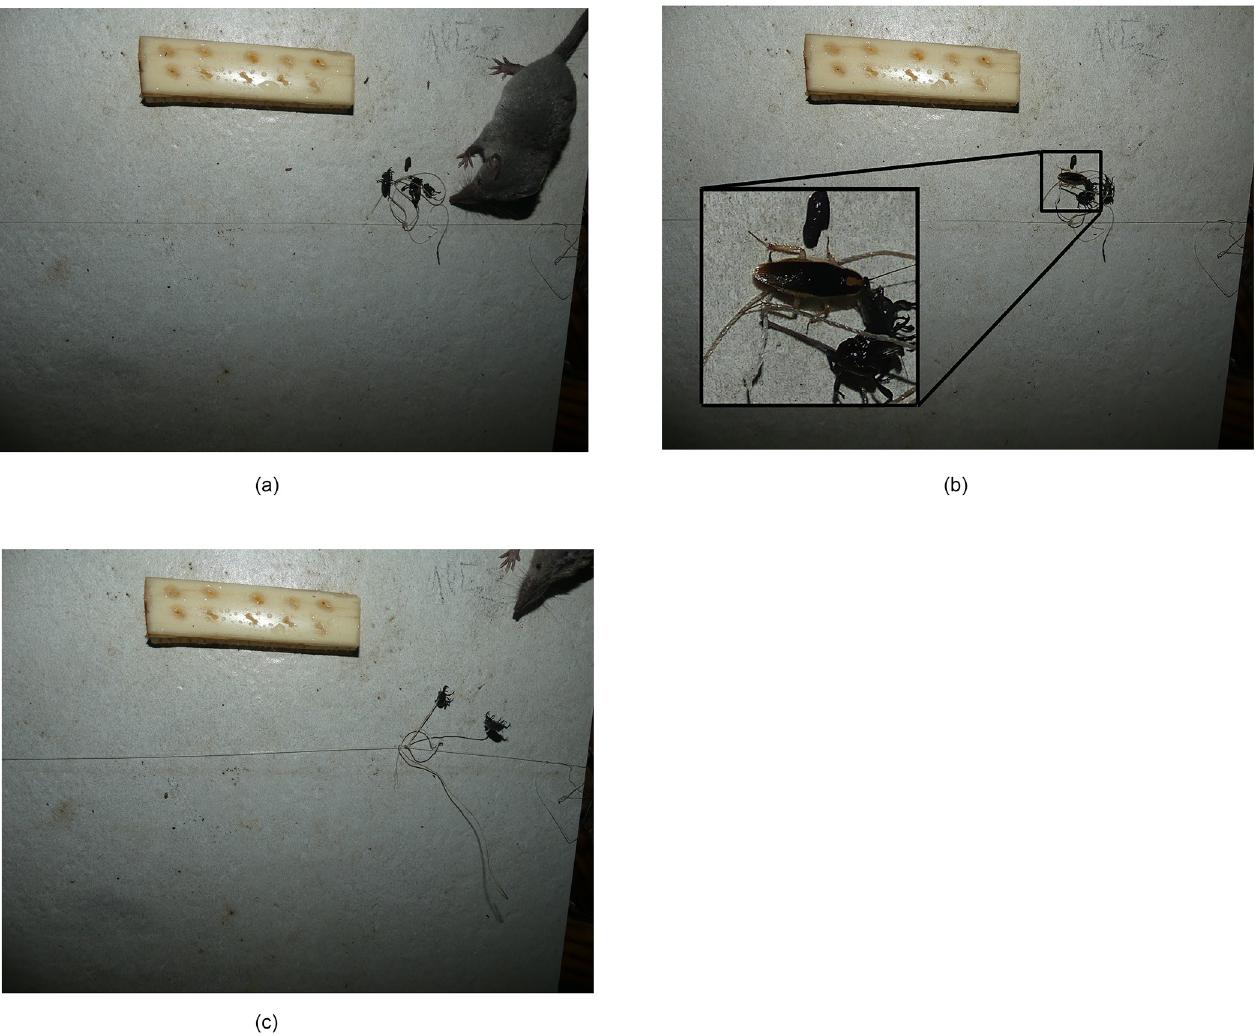
Fig 7. Example of hyper-predation. a) A shrew ( Suncus murinus ) captures a weevil at 19:27. b) A cockroach then feeds on the weevil remains for almost 1 h before c) it is captured by S . murinus at 20:24.